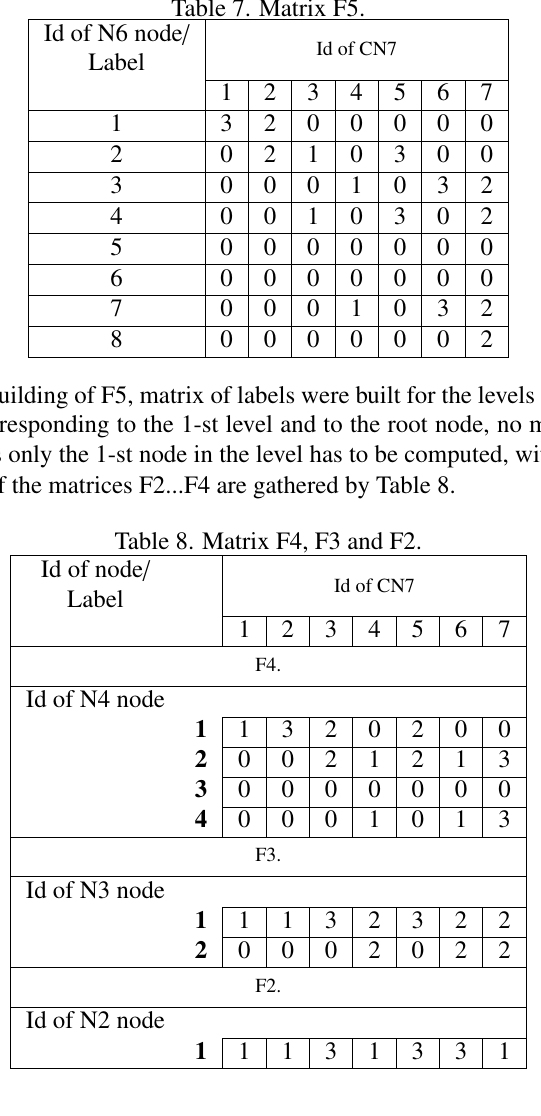
Table 7 gathers few rows from the matrix F5. Table 7. Matrix F5. Id of N6 node /